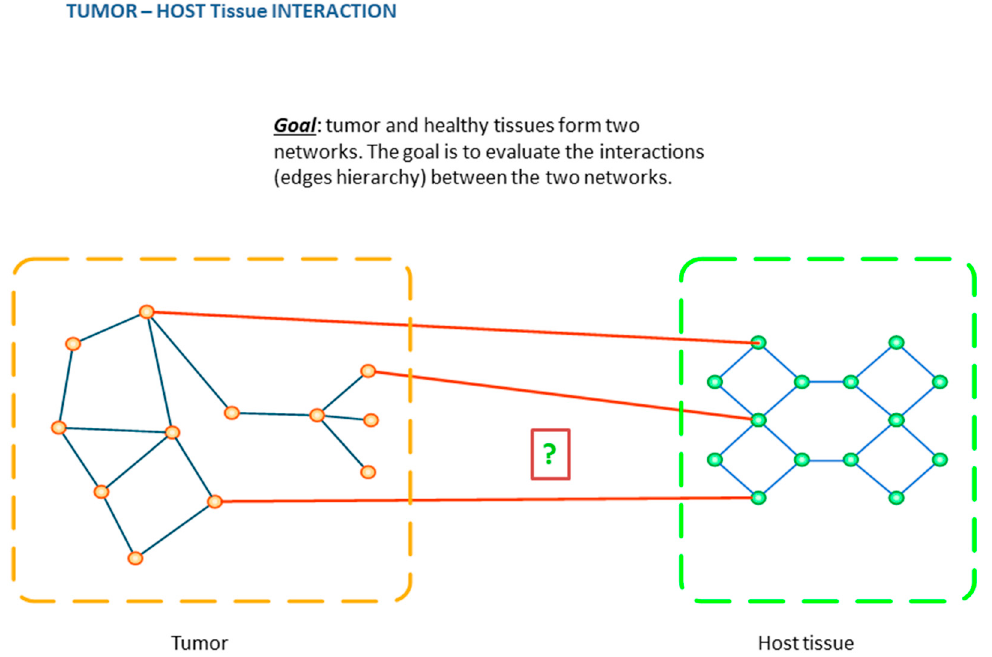
Figure 6. Use of networks to inspect tumor–host interaction dynamics. The network configurations in the two scenarios vary, with some common nodes that communicate differently.